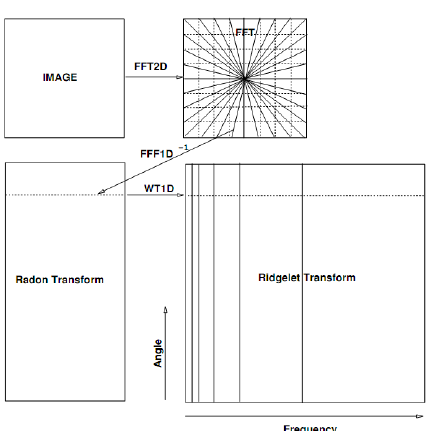
Fig. 2: Discrete ridgelet transform (Cand`es and Donoho,